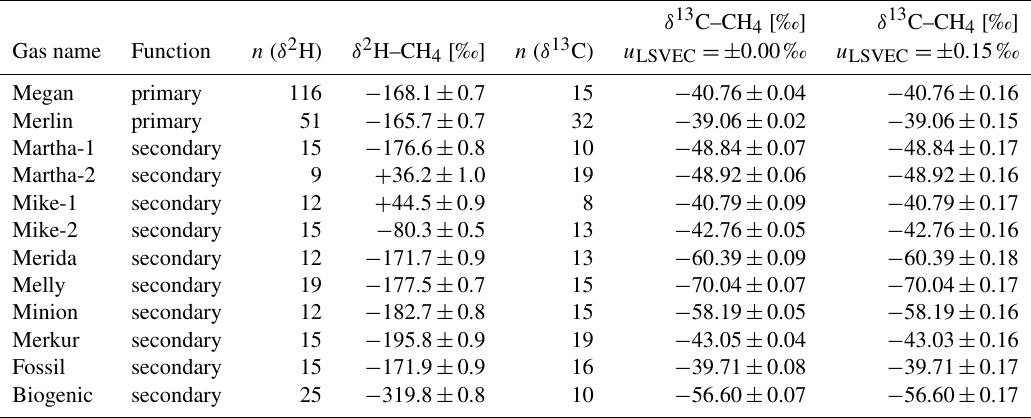
Table 3. Results of CH 4 isotope calibrations. Gas names as used in main text and their function as primary or secondary CH 4 are shown in column 1 and 2 respectively. All uncertainty estimates include the full traceability chain (Sect. 2.4). Note that we provide uncertainty estimates for δ 13 C–CH 4 without and with the uncertainty of 0.15‰ in LSVEC in column 6 and 7 respectively. Martha-1 and Mike-1 were intermittent gases and used to produce Martha-2 and